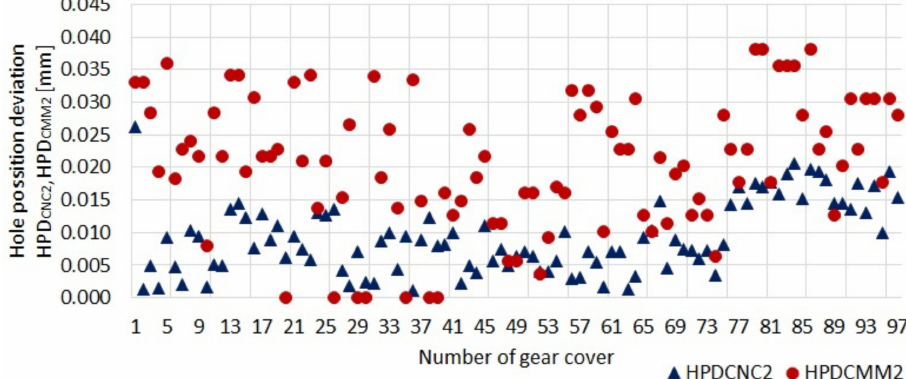
Figure 7. Hole position deviations of bearing seat 2 from nominal values determined on the basis of measurements on the CMM (HPD CMM2 ) and on the CNC machine (HPD CNC2 ).